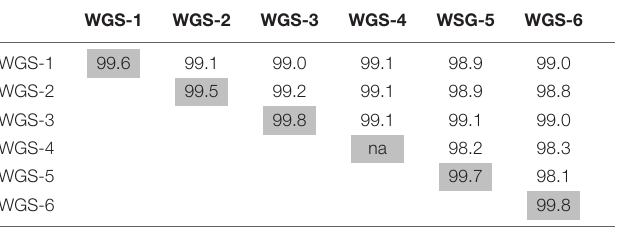
TABLE 3 | In silico genome to genome distance calculations between the most closely related MRSA and MSSA pairs in each sub-lineage, as well as between the most directly descended isolates in each